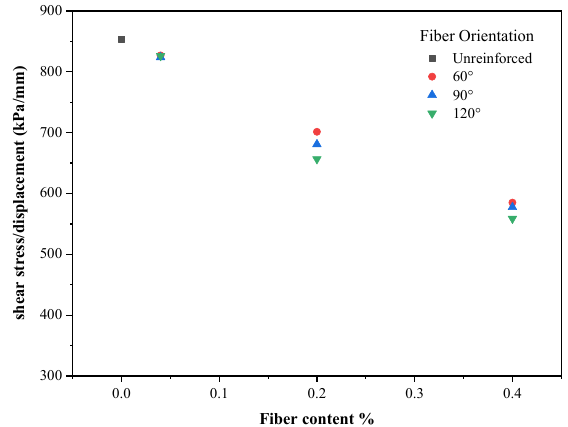
Figure 7. Initial stiffness of sand specimens under normal pressure of 200 kPa. Ductility reflects the deformation that can be sustained by soil from yield to a failure state. To intuitively illustrate the influences of fiber strips on sand ductility in this study, the failure displacements of the sand specimens, i.e., the displacement of the peak strength point, are shown in Figure 8 versus the fiber content. It can be observed that the failure displacement increased with fiber content, indicating that the introduction of fiber strips could improve the ductility of dense sand in this study. For the sand specimens with the same fiber content, the fibers initially orientated at 60° provided the largest ductility increments while the fibers initially orientated at 120° provided the smallest. Fiber strips may influence the ductility of dense sand via the same mechanism as residual strength. As discussed above, fibers can restrain the movement among sand particles and then reduce the volume dilation. Therefore, compared with unreinforced sand, the reinforced sand specimens may need larger macroscopic displacement in the direct shear tests for the degree of microscopic deformation of their internal structures to reach the failure degree.